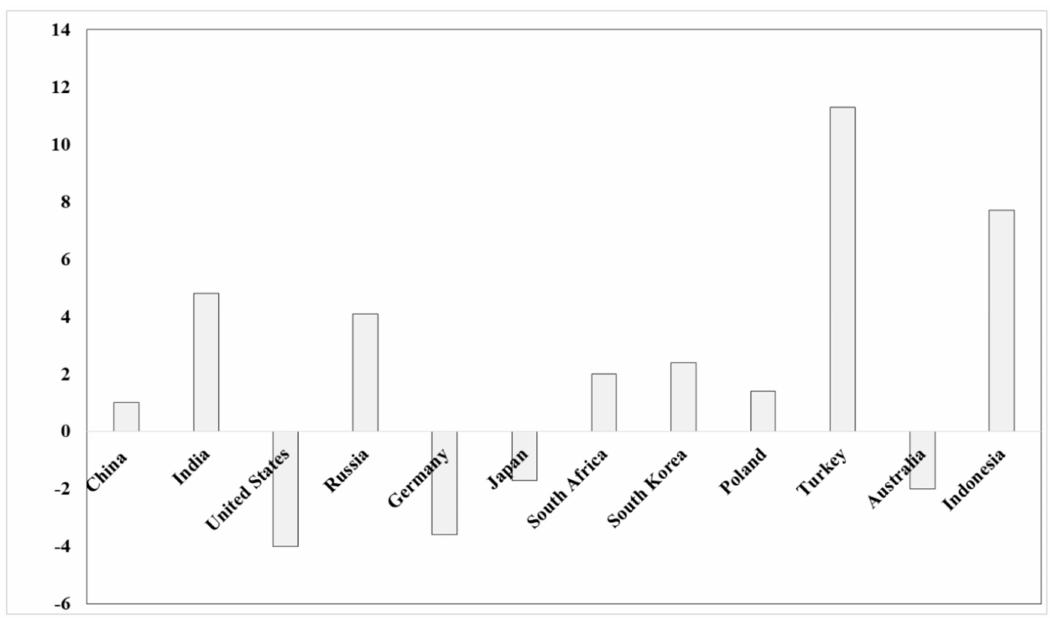
Figure 1. Global coal consumption (Mt) in 2018.